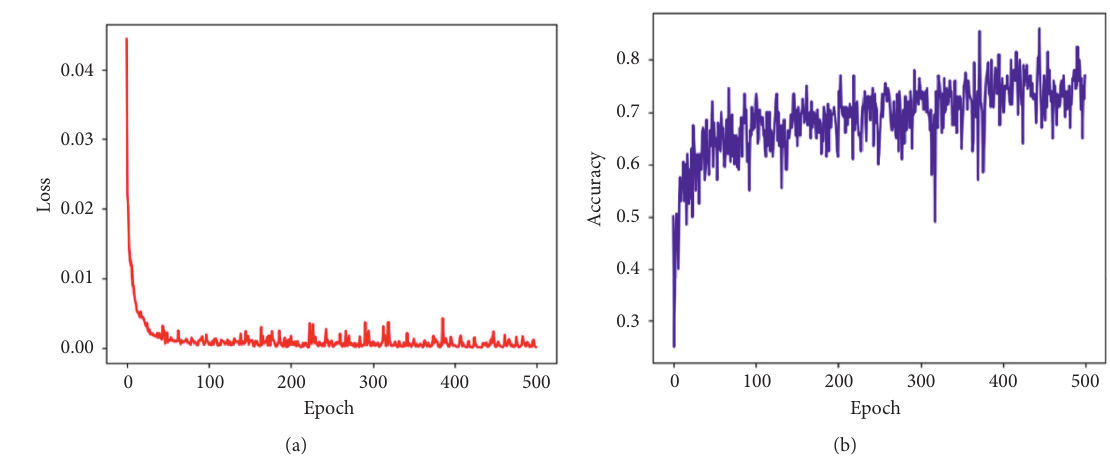
Figure 3: (a) Loss and (b) learning curves of our model: final accuracy � 98% for training dataset and 86% for validation